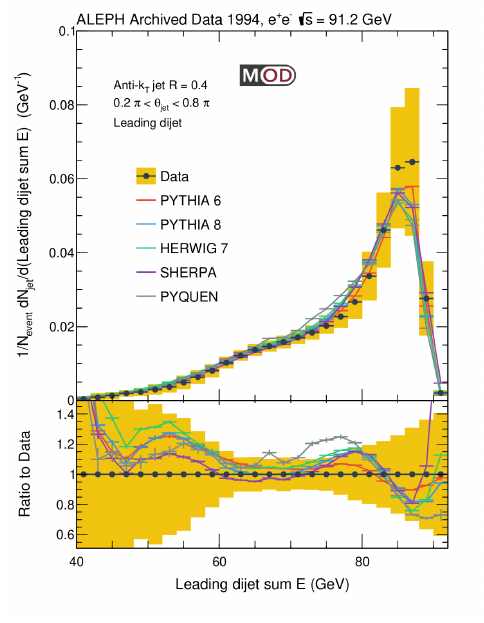
Figure 14 . Measured leading dijet sum E spectrum. The spectrum is normalized by the number of events used to perform the measurement. Any overflow contribution is included in the final bin. The data is also compared with predictions from Pythia 6 (red), Pythia 8 (blue), Herwig (green), and Sherpa (purple) generators. The predictions are normalized to have the same area as the